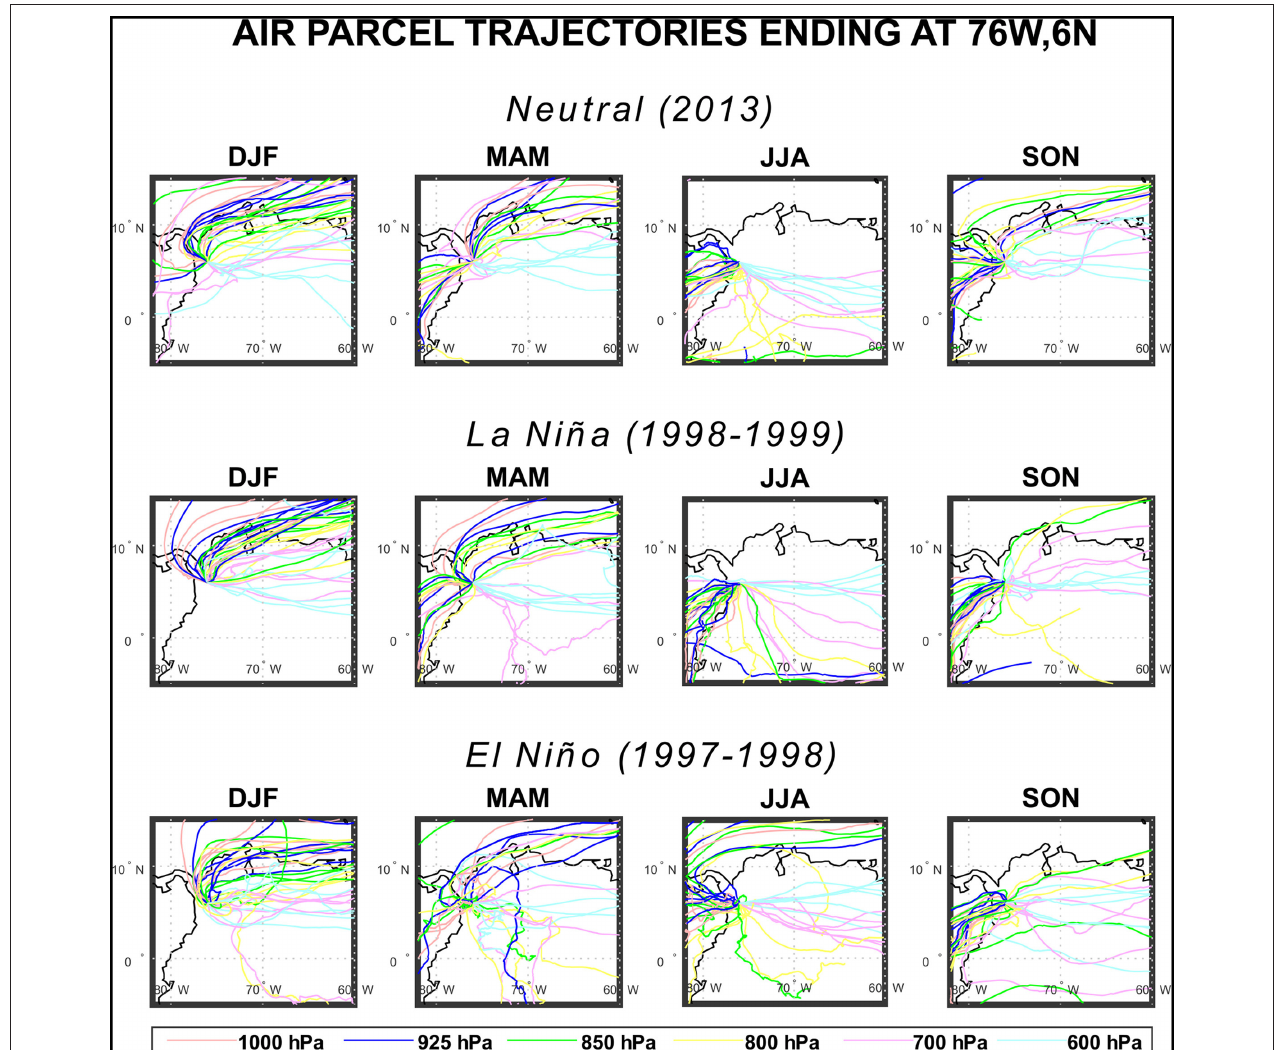
FIGURE 6 | Seasonal air parcel trajectories ending at 76W, 6N (Aburrá Valley) for a Neutral year (2013), La Niña (1998–1999) and El Niño (1997–1998) along 1,000, 925, 850, 800, 700 and 600 hPa. Data source: https://www.esrl.noaa.gov/psd/cgi-bin/data/trajtool/traj.pl.